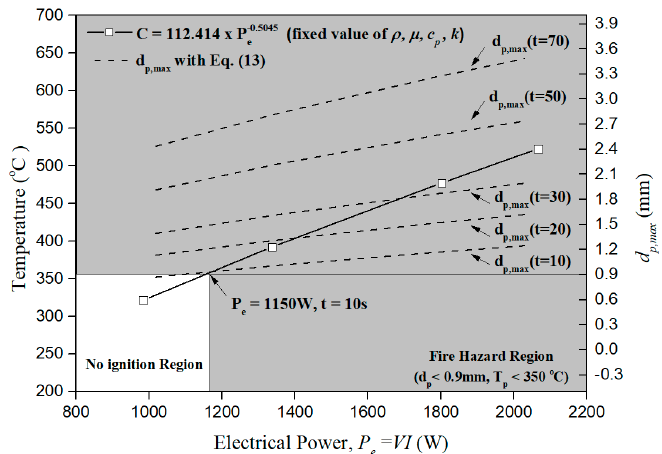
Figure 12. Predicted results of the maximum diameter and temperature of the welding particle depending on the electrical power and welding time.